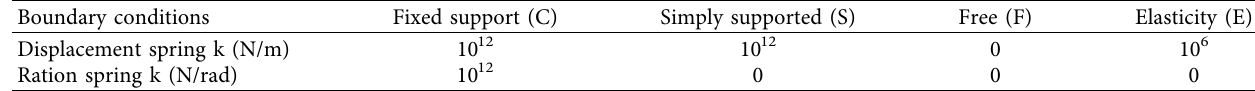
Table 2: The first ten-order dimensionless natural frequency Ω of the curved beam varies with the value of K Stiffness value 0